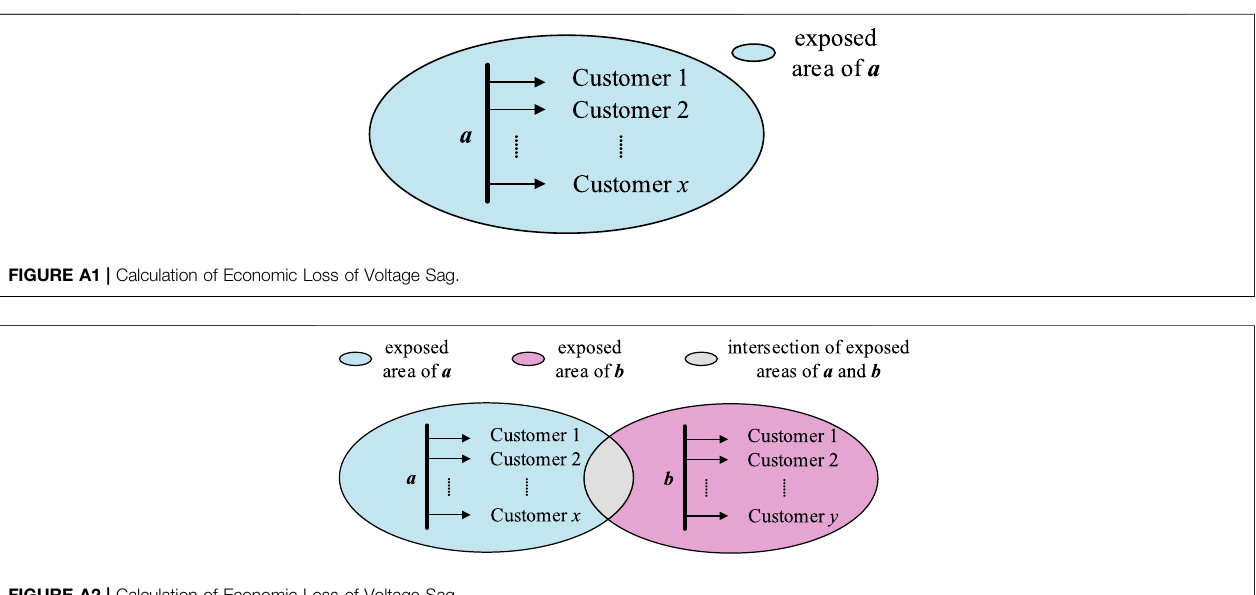
FIGURE A2 | Calculation of Economic Loss of Voltage